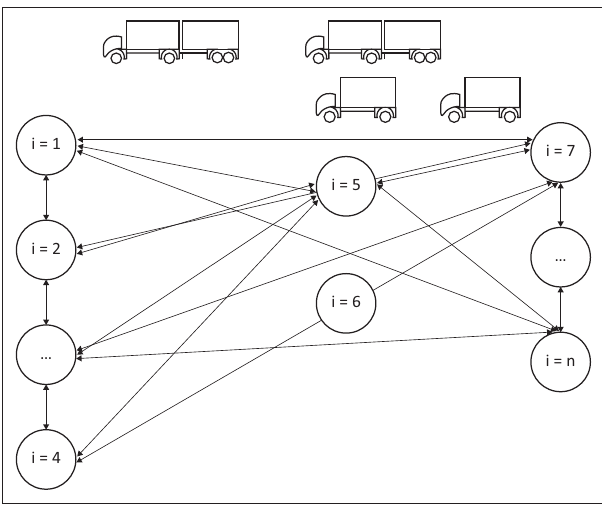
FIGURE 1: General structure of a fast-moving consumer goods supply chain with three